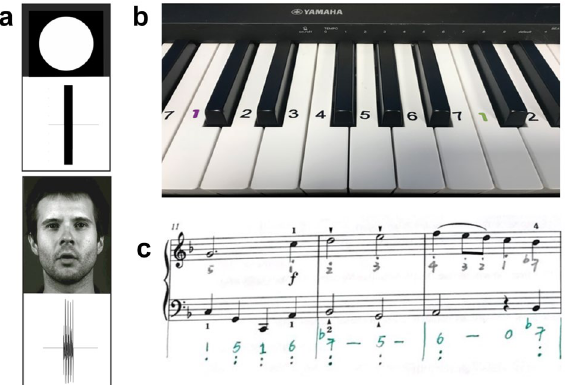
Figure 1. Stimuli and materials illustrations. ( a ) Video frame and waveform representations of the stimuli used in the simultaneity judgement task. The flash-beep (top) consists of a single flash on a black background accompanied by a single beep. The face-voice (bottom) consisted of a male face on a black background accompanied by a ‘o’ utterance. The area size of the white flash approximated that of the mouth area in the face- voice clip. ( b ) Numbered stickers were attached to the keyboard to guide the participants to find the correct key. ( c ) Numbered music notation were presented with the music score, the grey-colour numbers represented the right-hand part and the green-colour numbers represented the left-hand